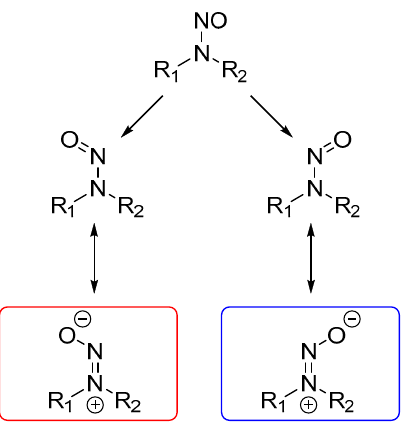
Figure 2. The possible mechanism of the generation of Z / E isomers of asymmetrical N-nitrosamines.